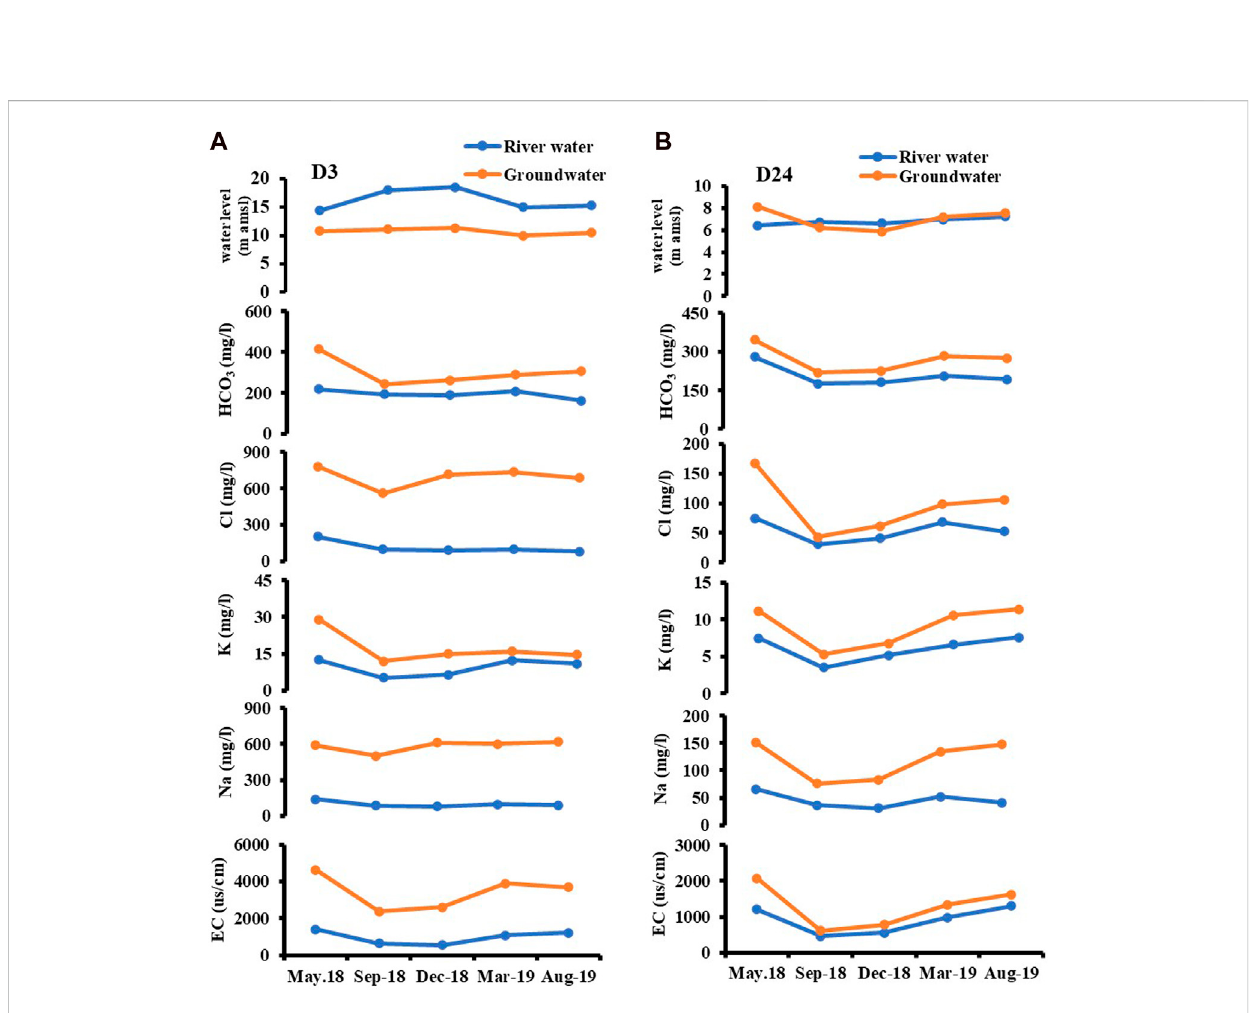
FIGURE 13 Temporal variation of river water and groundwater of locations (A) D3 and (B)